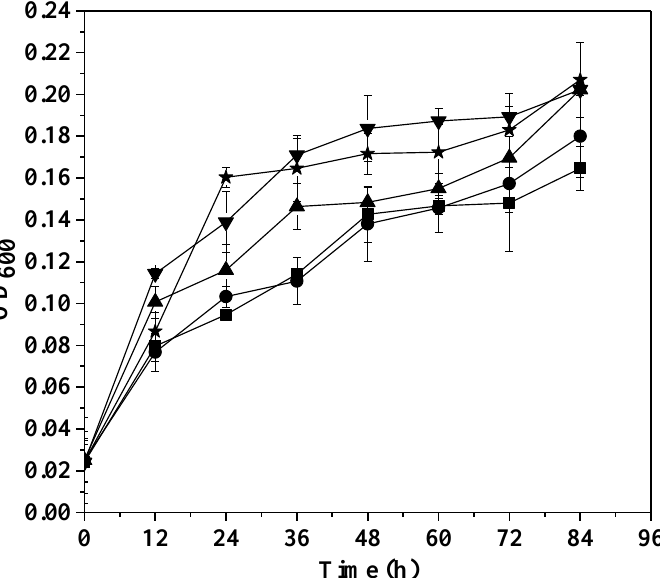
Figure 1. Growth of Clostridium sp. PXL2 at various U(VI) concentrations. ■ , control; ● , 4.2 µM; ▲ , 10.5 µ M; (cid:72) , 21.0 µ M; (cid:70) , 42.0 µ M. Data are presented as means ± standard deviations (SD) of triplicate measurements.